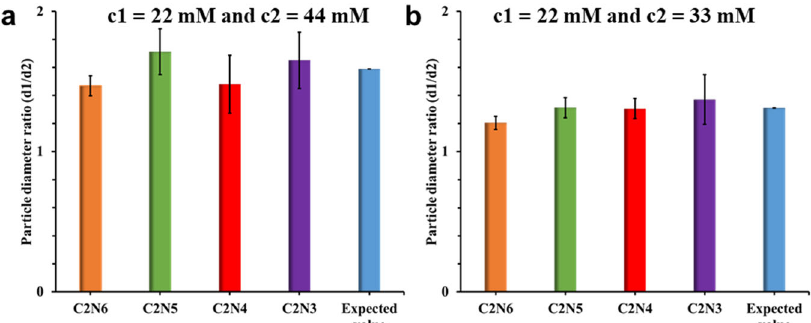
Fig. 6 Ratio of particle diameter at different polyamine concentrations obtained using the Eq. (3). a Polyamine concentrations c 1 = 22 mM and